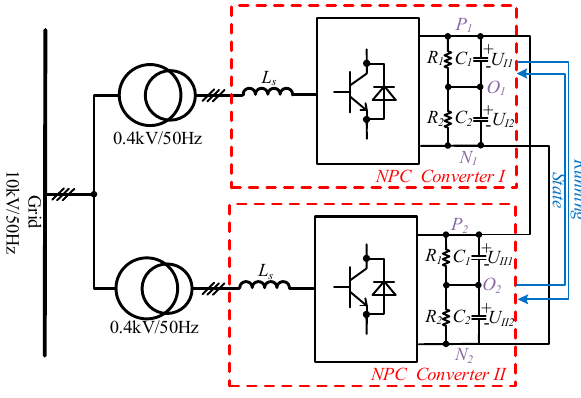
Figure 13. Experimental platform.